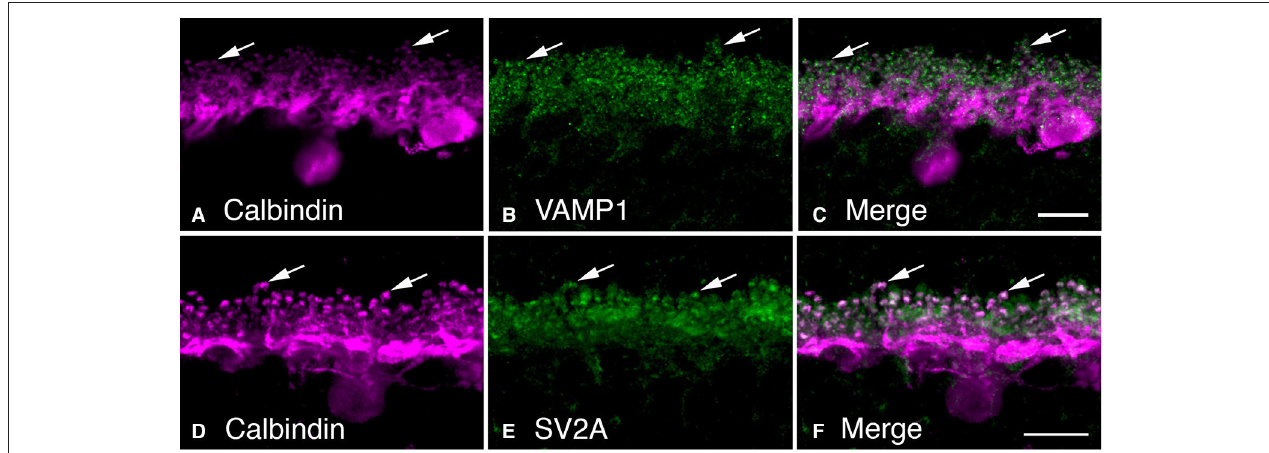
FIGURE 9 | Synaptic vesicle proteins, VAMP-1 and SV2A, are found in horizontal cell synaptic endings. (A–C) VAMP-1 immunolabeling ( B , green) was observed in the OPL of mouse retina. (B) Horizontal cells labeled with calbindin antibodies ( A , magenta). (C) Merged image demonstrated the co-localization of VAMP-1 and calbindin immunoreactivities in horizontal cell processes and particularly in the synaptic endings (arrows). (D–F) Synaptic vesicle protein SV2A immunolabeling (E) was present in the OPL as large puncta. (D) Horizontal cells identified by calbindin immunoreactivity (magenta). (F) Merged image shows co-localization of SVA and calbindin immunoreactivities in horizontal cell endings. There is also SV2A immunolabeling surrounding the horizontal cell endings, in likely photoreceptor terminals. Maximum intensity projections, A–C , z = 0.6 µ m; D–F , z = 6.42 µ m. (Modified from Bitzer and Brecha, 2006; Brecha et al.,